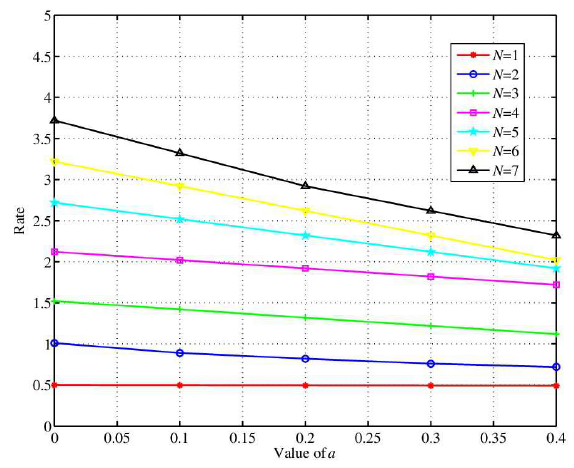
Figure 6. The change of bit generation rate with α different dimensions.